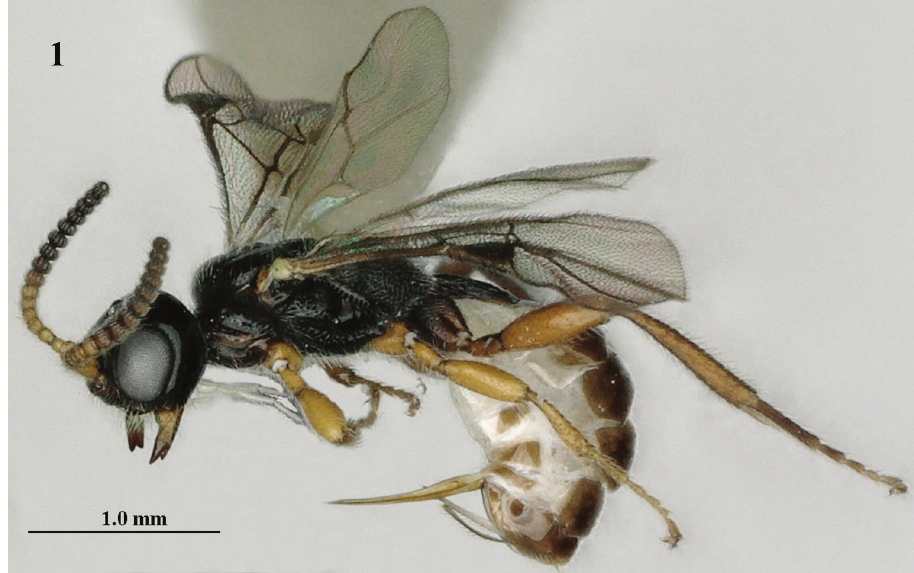
Figure 1. Mannokeraia albipalpis sp. n., ♀ , holotype, habitus, lateral aspect. Diagnosis. Antenna of ♀ with 20 segments and medially slightly widened (Fig. 11), and basal 7 segments brownish yellow and apical 12 segments strongly moniliform, of ♂ scapus and pedicellus yellow and following 5 segments brown or dark brown; palpi white; with transverse space between clypeus and closed mandibles; head moderately enlarged behind eyes in dorsal view (Fig. 9); length of malar space 0.3 times basal width of mandible (Fig. 8); mesosoma of ♀ normal, with mesoscutum far above upper level of pronotum (Fig. 3); pronotum and mesoscutum black; propodeum rugose medially (Fig. 4); legs (except hind coxa) largely brownish yellow or yellowish brown; setose part of ovipositor sheath 0.5–0.6 times as long as hind tibia; both sexes macropterous. Description. Holotype, ♀ , length of fore wing 2.9 mm, and of body 3.7 mm. Head. Antenna with 16+ segments (apical segments missing, ♀ paratype has 20 an- tennal segments), length of third segment 1.1 times fourth segment, third and fourth segments 1.1 and 1.0 times as long as wide, respectively (Fig. 11) and with apical 9+ segments pedunculate, medially antenna wider than as apically; length of maxillary palp equal to height of head; occipital carina complete, comparatively low dorsally (Fig. 10), joining hypostomal carina below mandible and occipital flange elongate; eye 1.3 times as long as temple in dorsal view; temples subparallel-sided behind eyes; OOL:diameter of posterior ocellus:POL = 13:5:11; vertex and frons smooth and strongly shiny, with some long setae, convex, without median groove, and anteriorly flattened; face sparse- ly coarsely punctate and with some superficial rugae (Fig. 8); clypeus depressed and smooth ventrally, with ventral rim slightly upcurved, dorsally weakly convex and with some coarse punctures; length of malar space 0.3 times basal width of mandible;